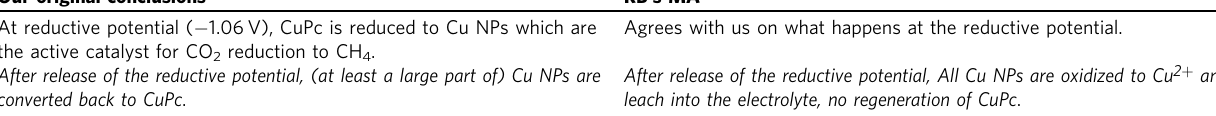
Agrees with us on what happens at the reductive potential.